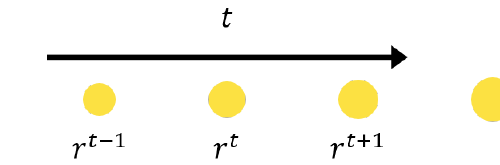
Figure 9. An illustration of the changing of the normalized size of a fragment.